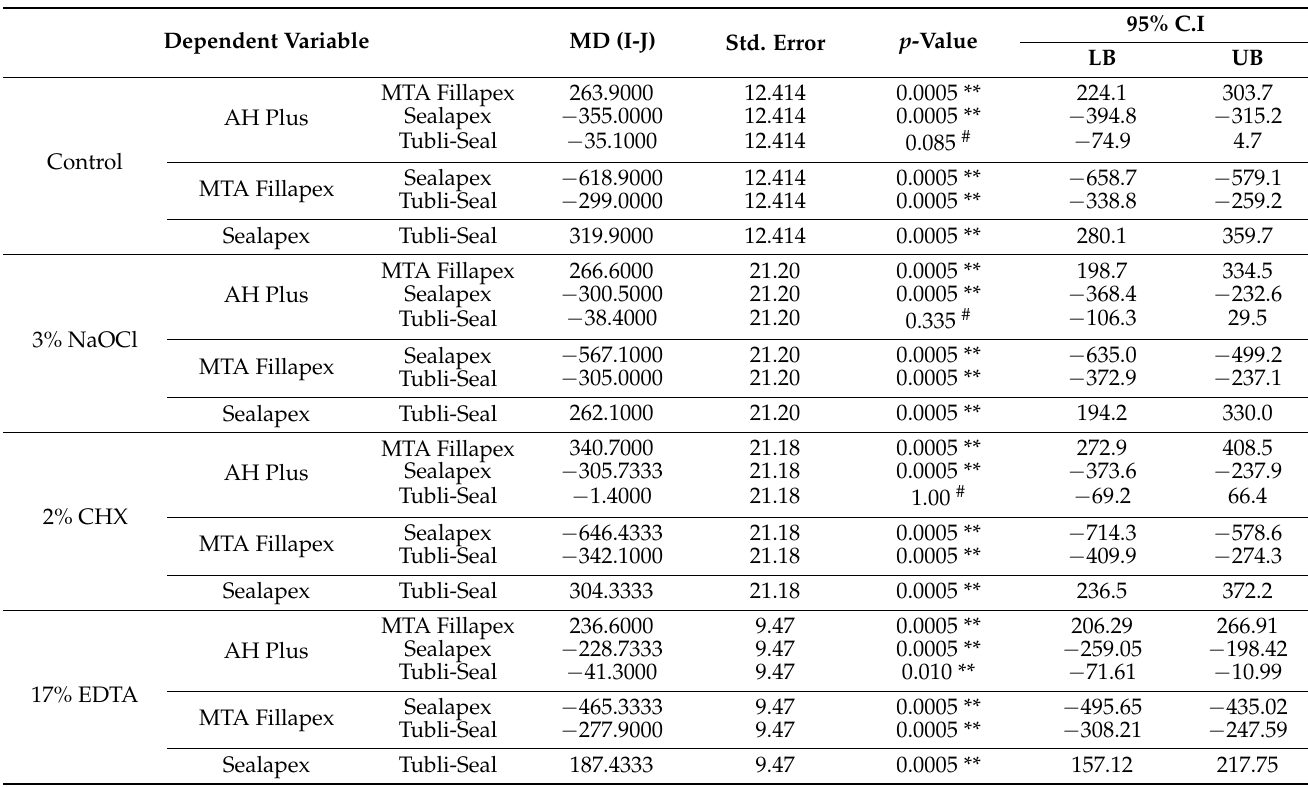
Table 4. Intragroup comparison using post hoc tukey test showed a significant difference in all the test groups ( p < 0.05) except for AH Plus-Tubli-Seal group ( p > 0.05) on interaction with 3% NaOCl and 2%